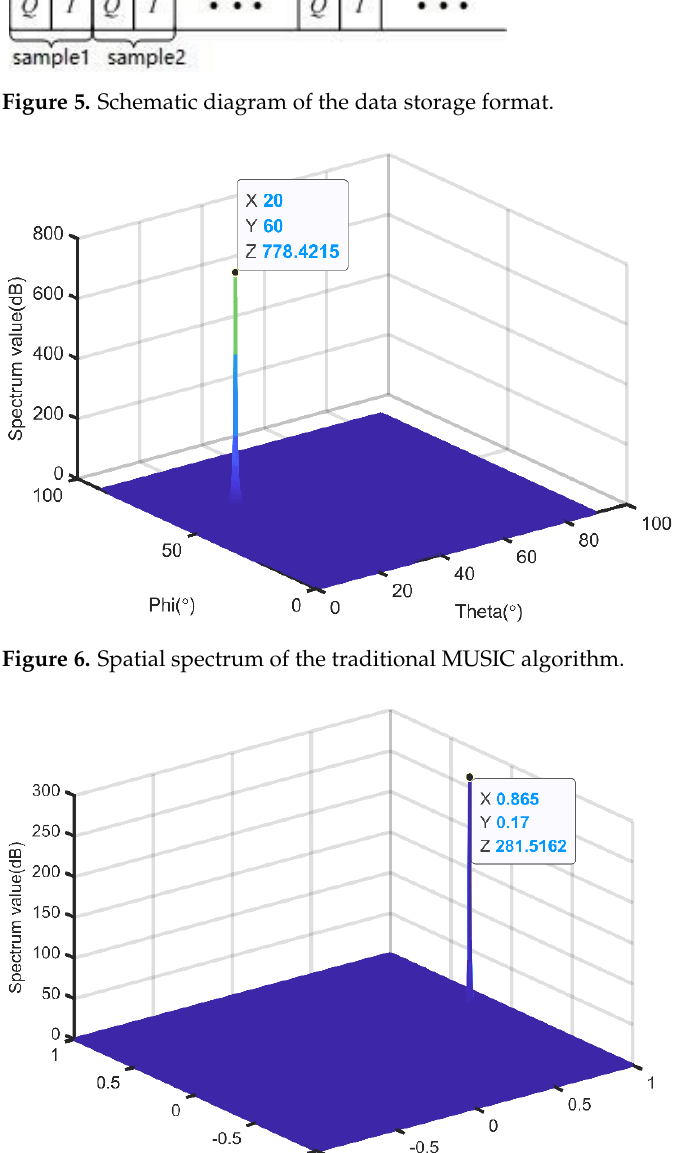
Figure 7. Transform domain spectrum of our algorithm.